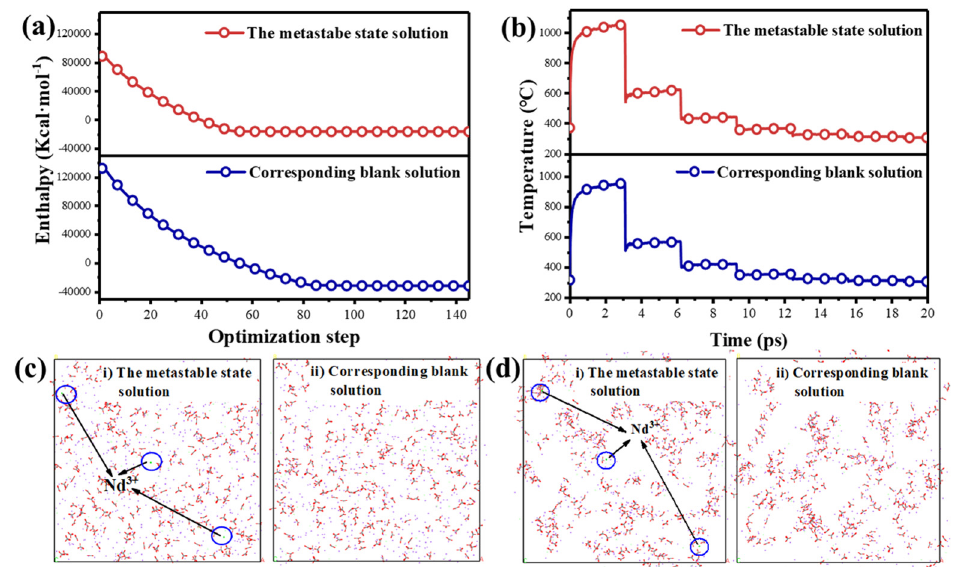
Figure 5. Geometry optimization process of the solution model ( a ). Temperature change during the MD calculation in ( b ). Geometry optimization and after MD calculation of the solution model ( c , d ). In the figures, ( i ) refers to the metastable state solution and ( ii ) is the corresponding blank solution.